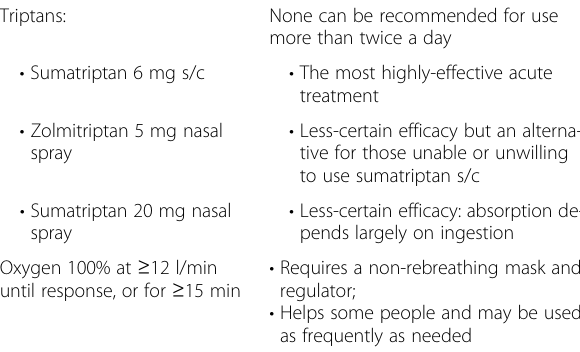
Table 13 Acute therapies used in cluster headache by specialists